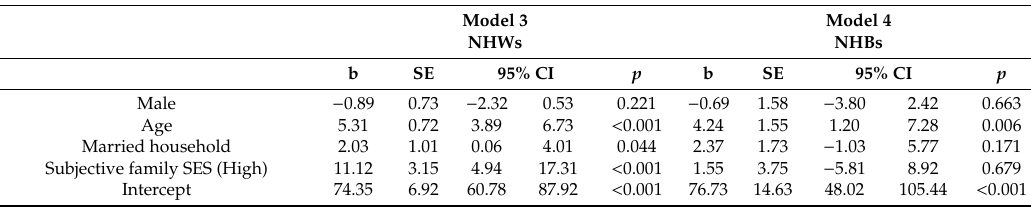
Table 4. Linear regression models by race ( n = 4188)